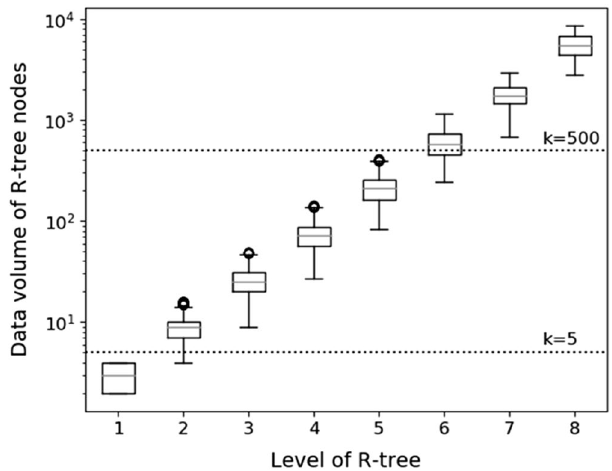
Figure 4. The statistical features of data volume of R-tree nodes in R Yelp